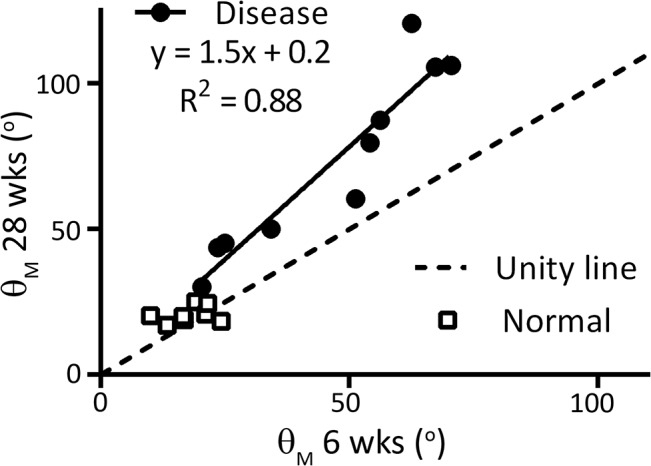
Progression of Deformity.Linear regression comparing spine deformity at 6 weeks to 28 weeks post-natal age is shown.